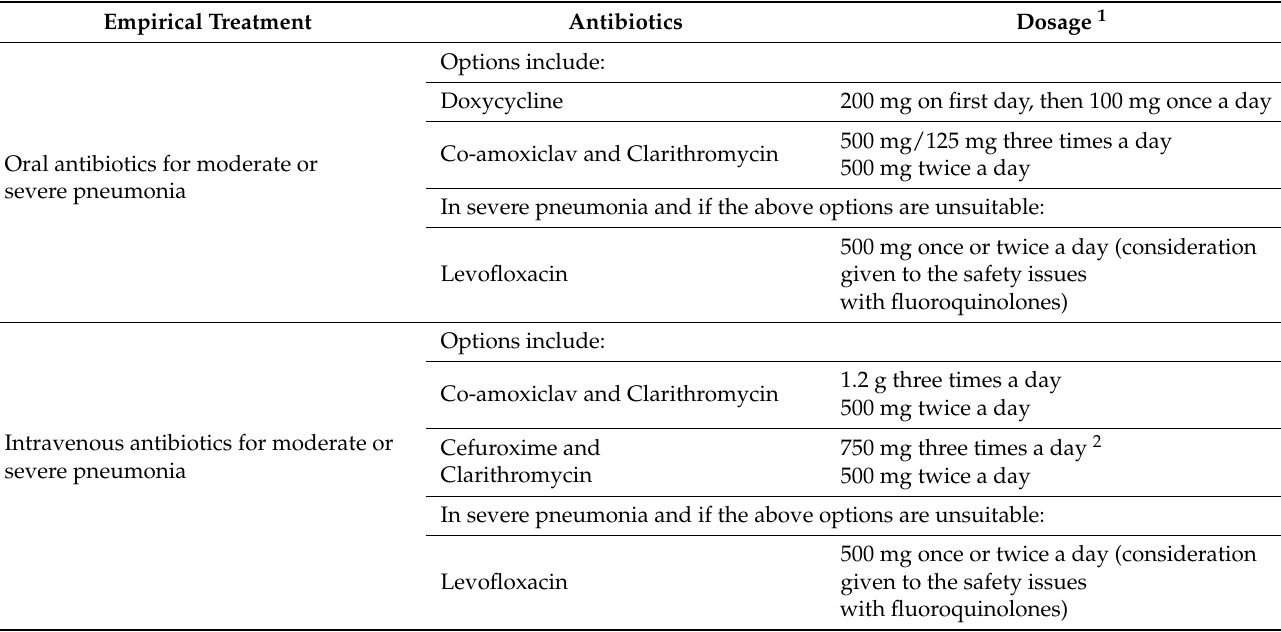
Table 2. NICE Guidelines for Antibiotic use for people older patients aged 18 and older with suspected community-acquired pneumonia (adapted from ref.